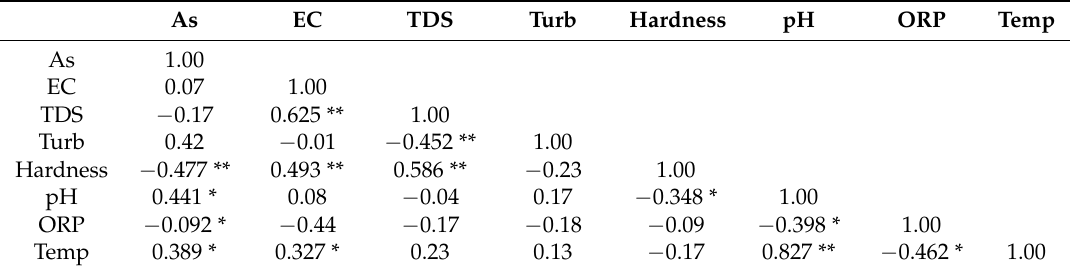
Table 3. Pearson correlation among the PhP in the wells of the ID005, sampling 1 (S1).